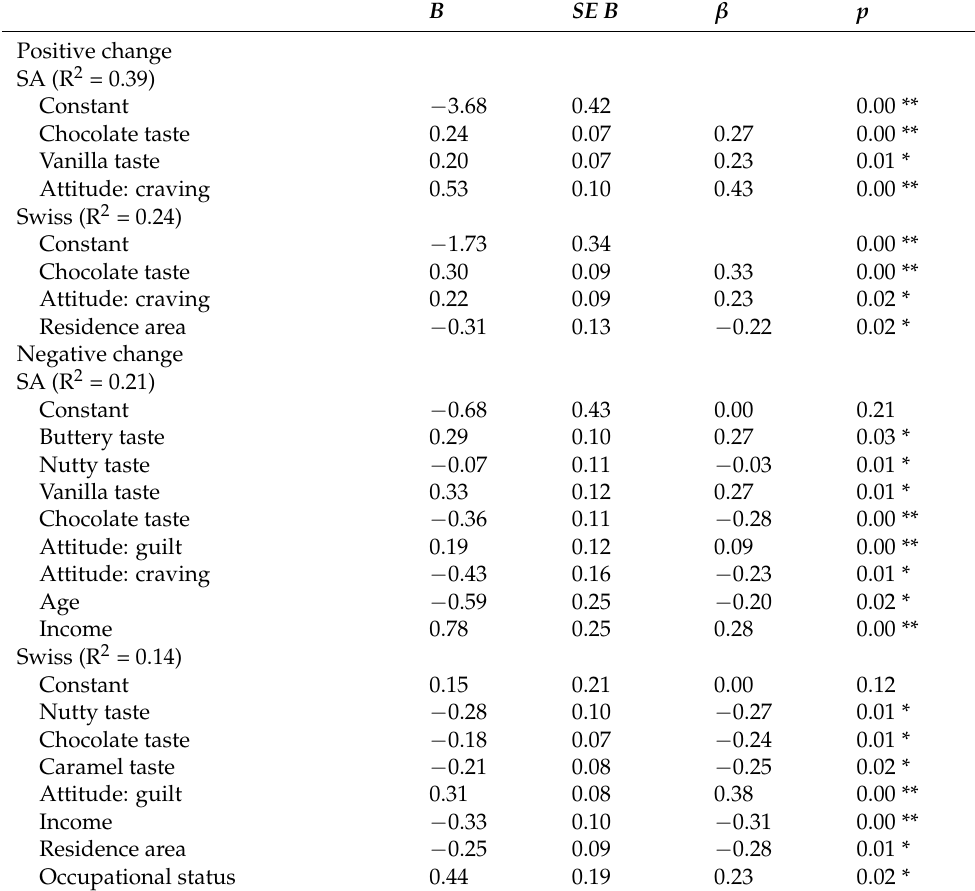
Table 7. Summary of regression analysis for the variables predicting consumers’ emotional changes. B SE